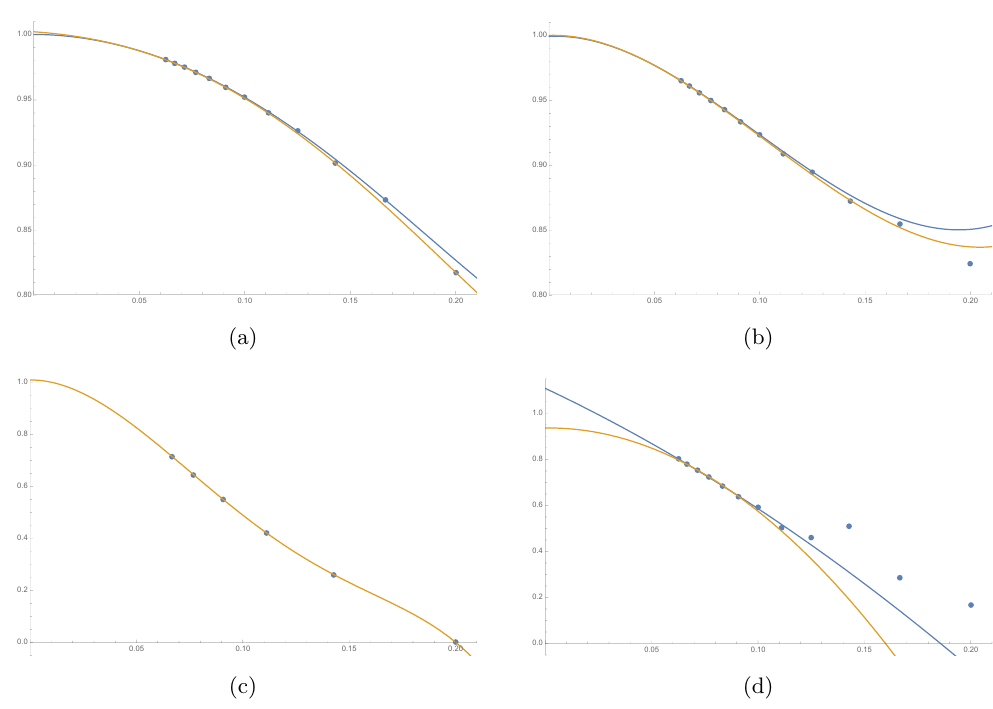
Figure 10 . Measures of the (cid:12)rst four amplitude ratios in G aaaa for the Ising model, divided by the expected analytical results. The respective panels show the contributions from (a) the energy operator (cid:15) , (b) its (cid:12)rst descendent ( L (cid:0) 1 + (cid:22) L (cid:0) 1 ) (cid:15) along with the stress tensor T + (cid:22) T , (c) its second descendent (cid:22) L (cid:0) 1 L (cid:0) 1 (cid:15) , and (d) the quantity T (cid:22) T . All data is shown against 1 =L . The extrapolations for even and odd L are shown respectively as blue and orange